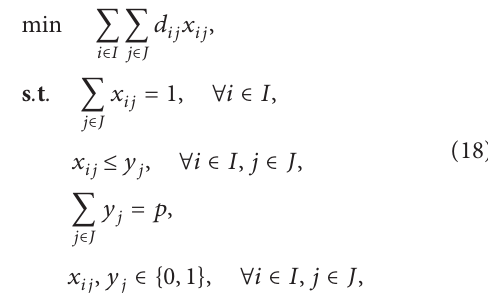
Figure 3: Chromosome decoding